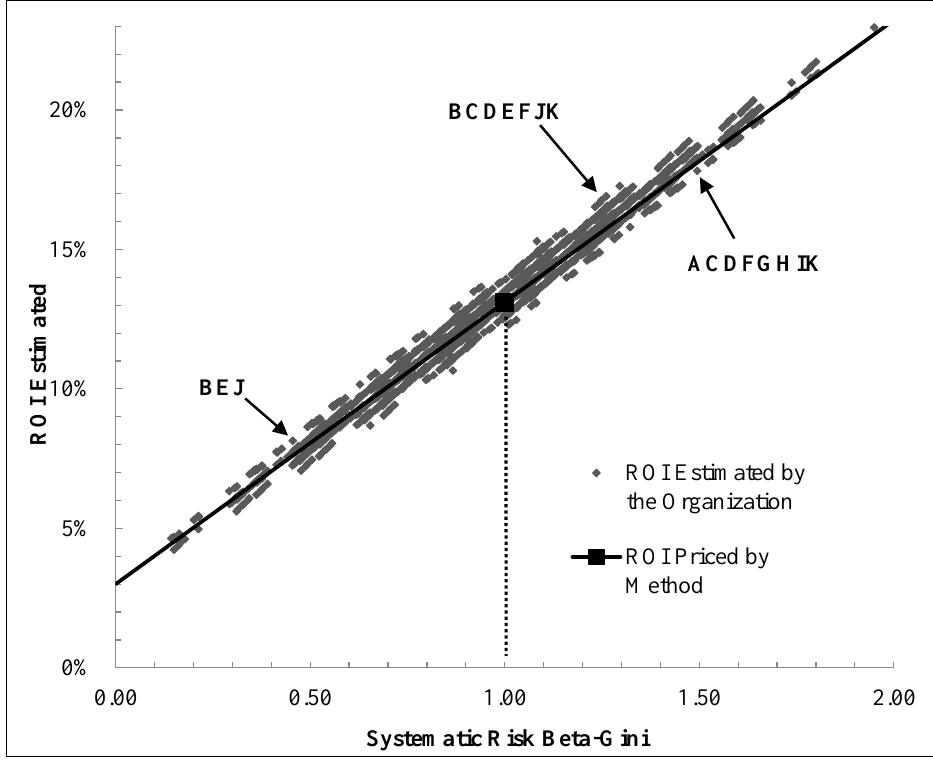
Figure 3. Similar security market line and return predicted by the small enterprise.